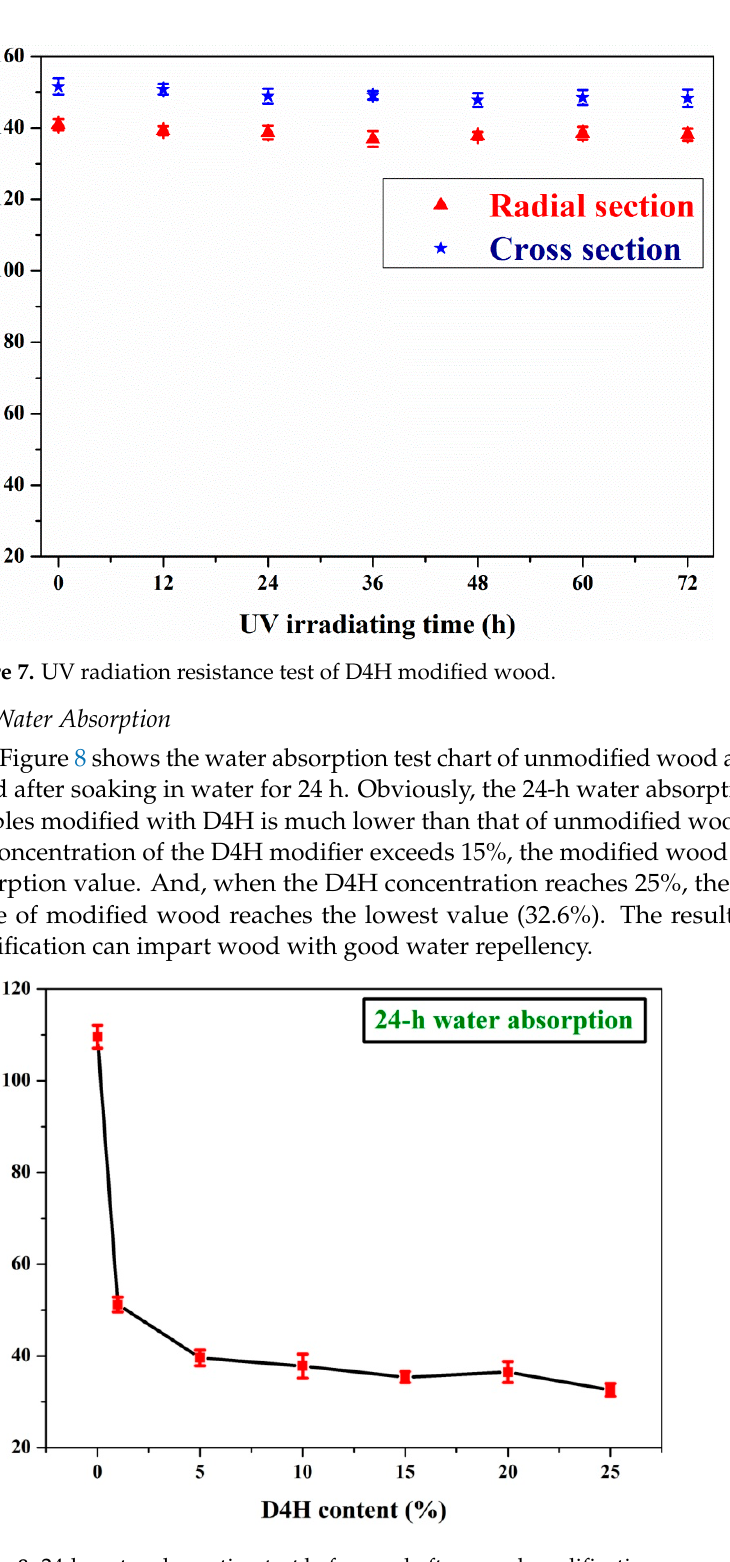
Figure 8. 24-h water absorption test before and after wood modification.